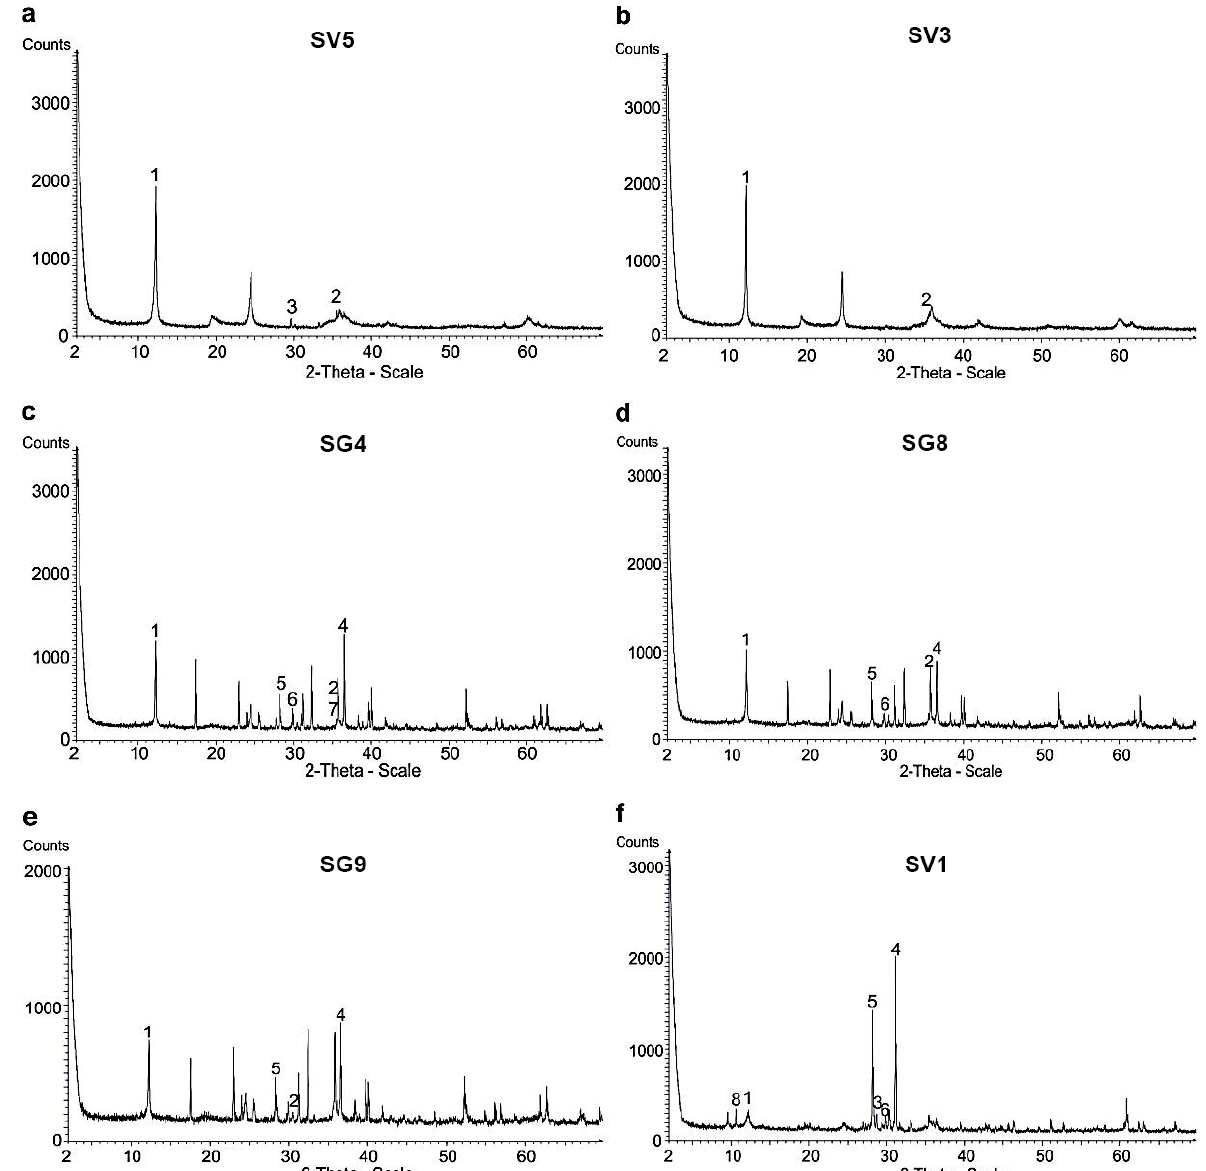
Figure 5. Representative X-ray diffraction patterns of the studied ultramafic rock samples where: ( a ) sample SV5; ( b ) sample SV3; ( c ) sample SG4; ( d ) sample SG8; ( e ) sample SG9; ( f ) sample SV1. Sample numbers are indicated as insets (1: serpentine, 2: spinel, 3: talc, 4: olivine, 5: orthopyroxene, 6: clinopyroxene, 7: magnetite, 8: